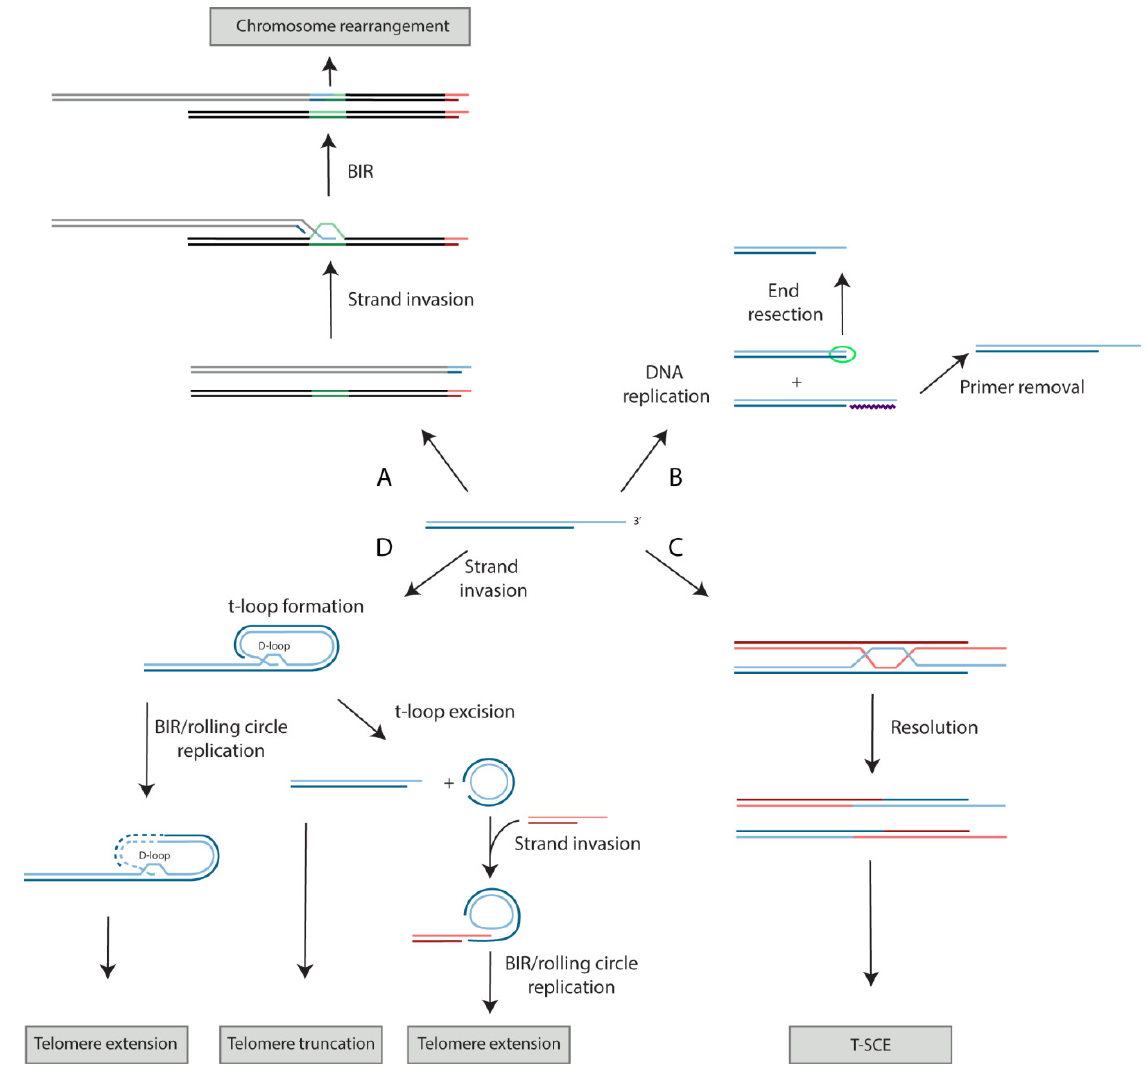
FIGURE 2: Recombination activities mediate a variety of telomere processes. (A) Strand invasion of a telomere into interstitial telomere sequence (green) located on the same (not shown) or different chromosome can lead to genome rearrangement. Depicted here, a segment of the invaded chromosome (black) is duplicated. (B) Replication of a telomere leads to two sister telomeres. The one synthesized by the lagging strand replication machinery will have an RNA primer (purple zigzag line) at its 5 ¢ terminus, while the other will have a blunt end (circled in green). Removal of the RNA primer on the former will lead to the regeneration of a 3 ¢ overhang while the latter must be 5 ¢ end resected. (C) A model for a T-SCE event. The blue and red lines depict sister telomeres. (D) A t-loop forms via the strand invasion of the telomeric 3 ¢ single-stranded overhang into double-stranded telomeric DNA of the same telomere. Excision of a t-loop yields a truncated telomere. Rolling circle DNA replication can be used to extend a telomere in a t-loop configuration, or a telomere (red) that has strand in- vaded a DNA circle containing telomeric repeats. Dashed lines indicate newly synthesize